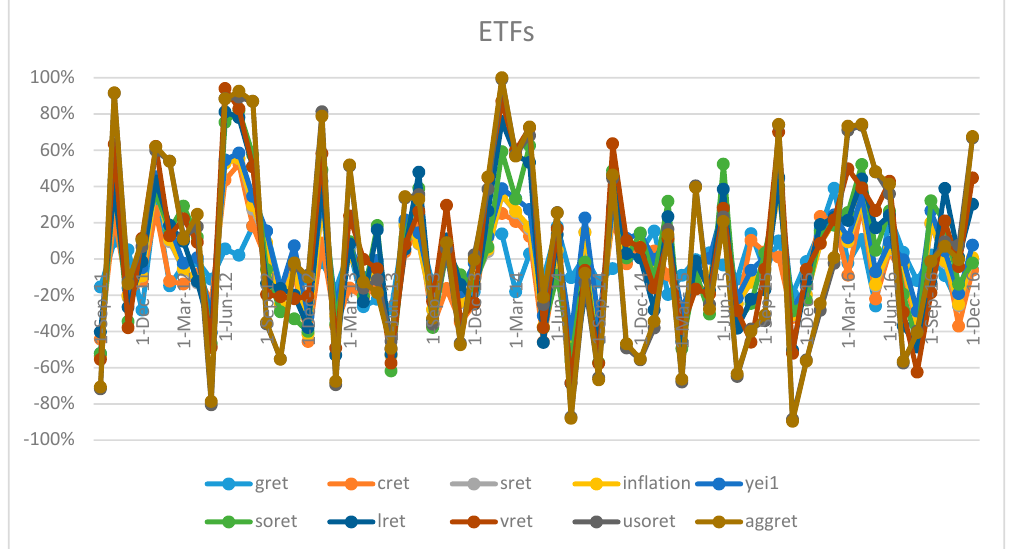
Figure 2. ETF returns graph.